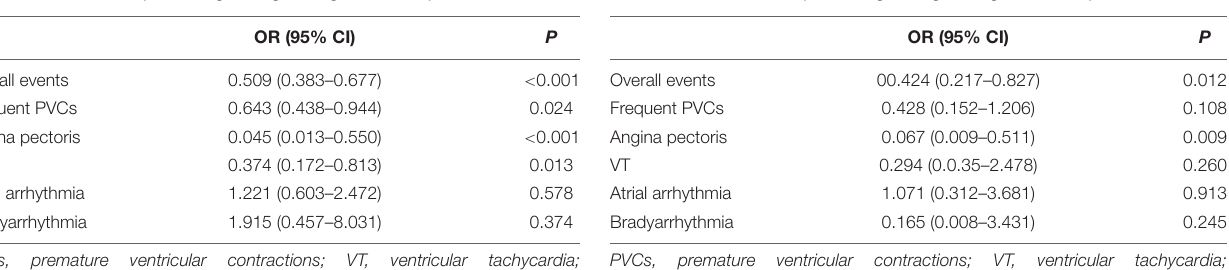
TABLE 4 | Correlation analysis between the occurrence of CV events and treadmill exercise in the male subjects using the logistic regression